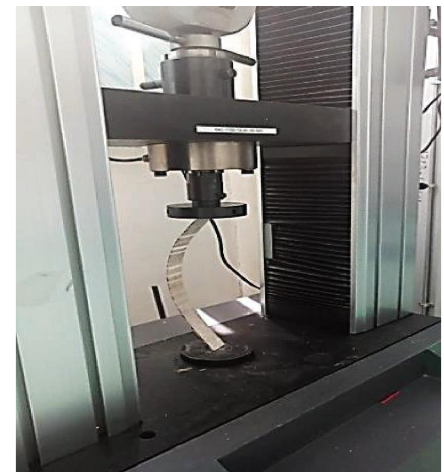
Figure 17: Buckling test setup.